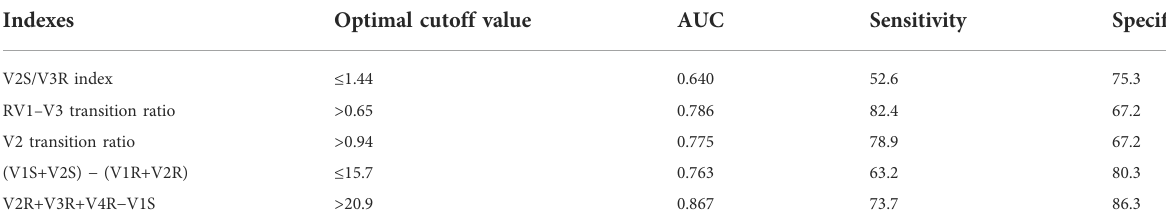
TABLE 3 Comparison of the novel ECG criterion with the previous ECG methods.